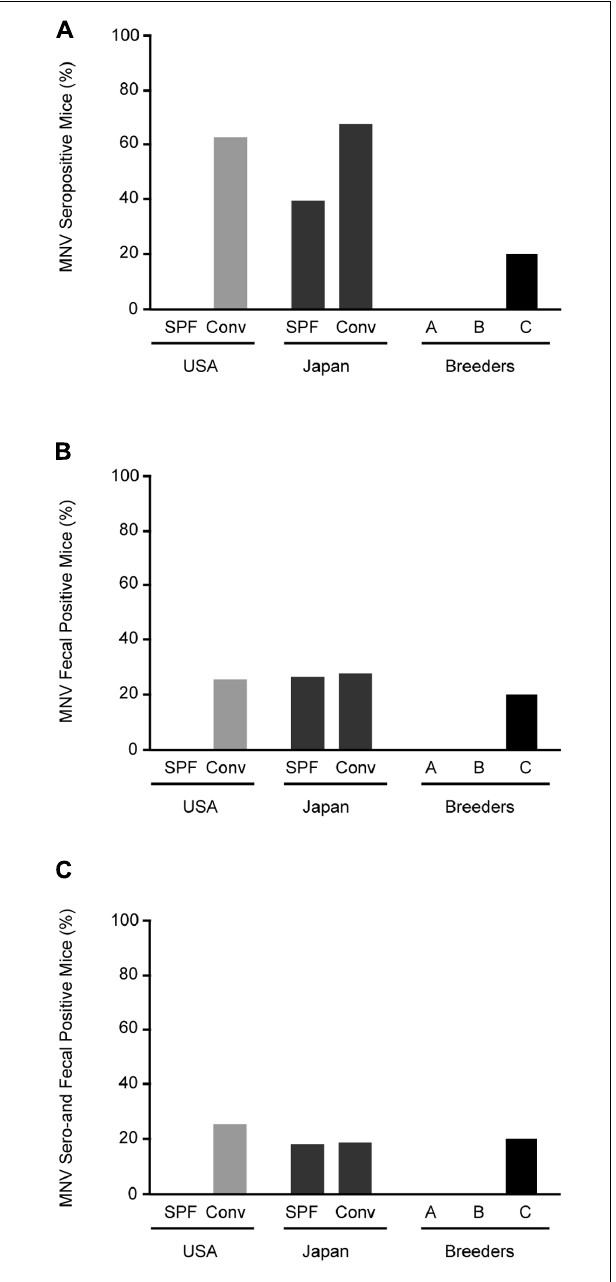
FIGURE 2 | Prevalence of MNV infection in conventional and SPF mice. (A) MNV seropositive mice from animal facilities in Japan and the US and breeders in Japan. (B) RT-PCR detection of MNV sequences in feces from tested mice. (C) Mice positive for both MNV antibodies by ELISA and MNV-specific sequences in feces by RT-PCR. SPF, specific pathogen-free; Conv,